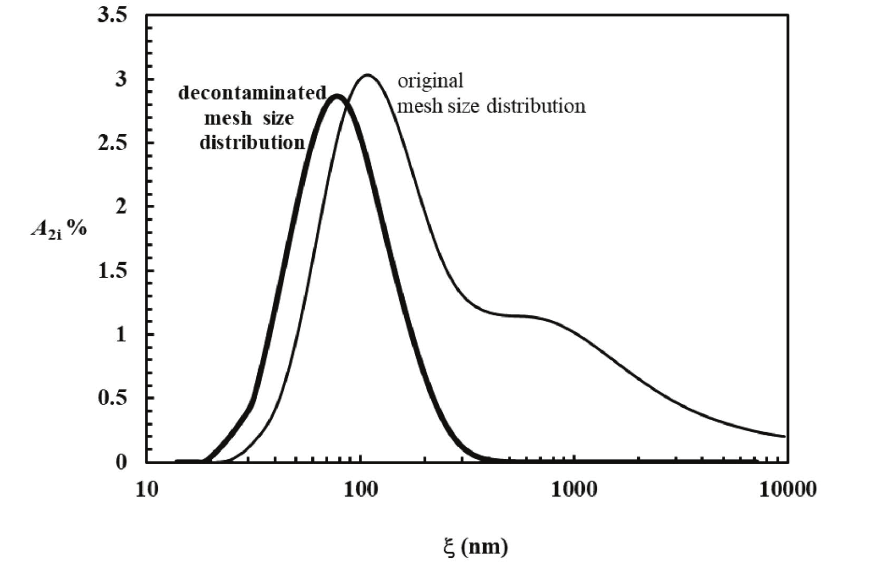
Fig. 7 – Comparison between the decontaminated (thick line) and the original (thin line) mesh size distribution obtained via Eq.(22) from the time relaxation distribution shown in Fig. 6 and referring to sample 1 of Tables 1 and 2. x is the mesh